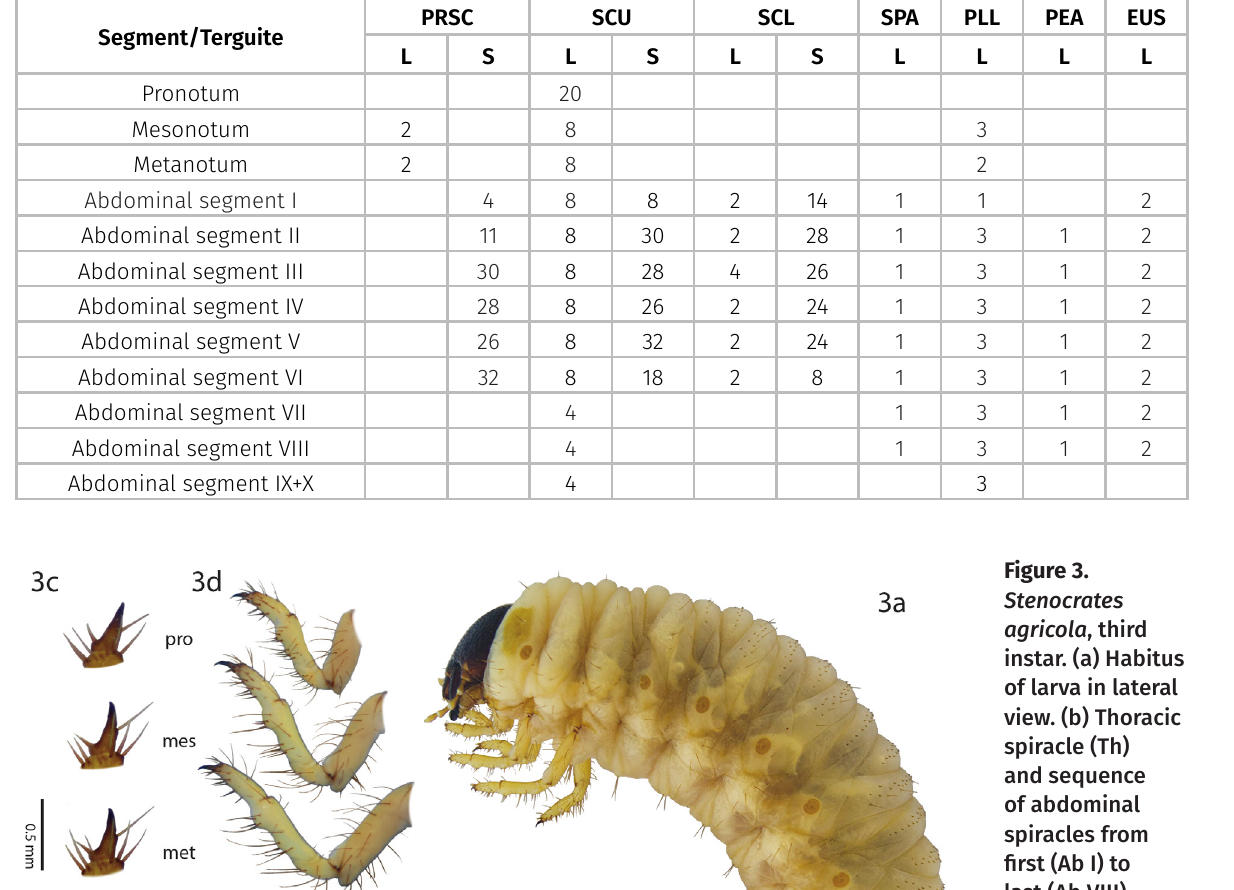
Table II. Chaetotaxy on thoracic and abdominal segments of third instar Stenocrates agricola . Long (L) and short setae (S) are mentioned for prescutum (PRSC), scutum (SCU), scutellum (SCL), spiracular area (SPA), pleural lobe (PLL), pedal area (PEA) and eusternum